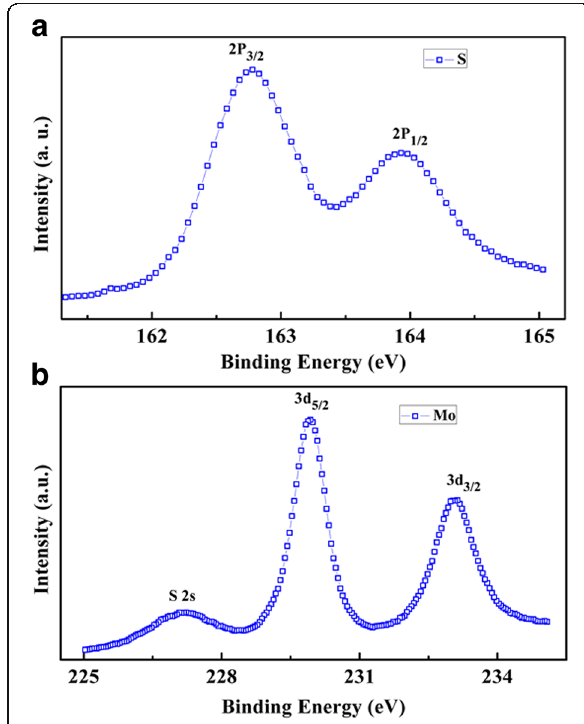
Fig. 2 XPS spectra of the MoS 2 film for a Mo and b S elements,